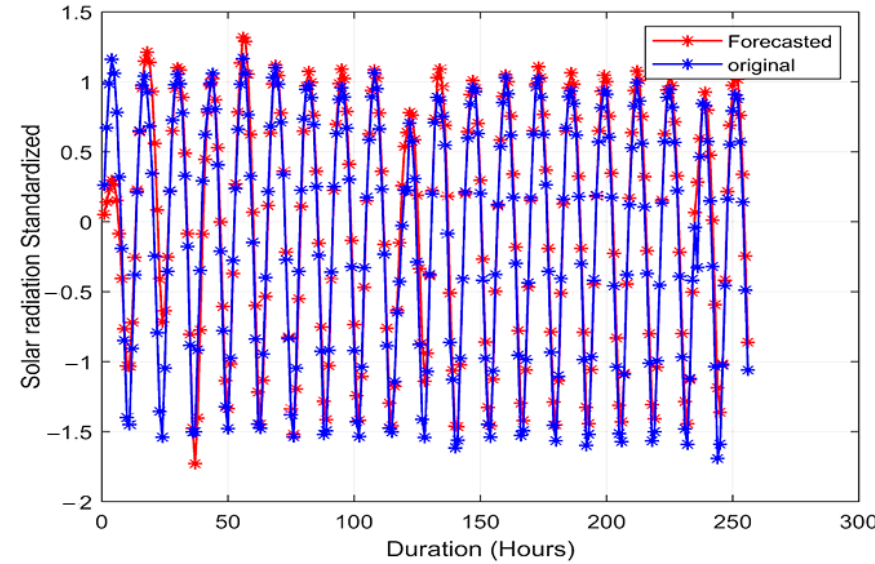
Figure 7. Solar radiation forecasted in the summer season (from 21 June to 20 September 2020).